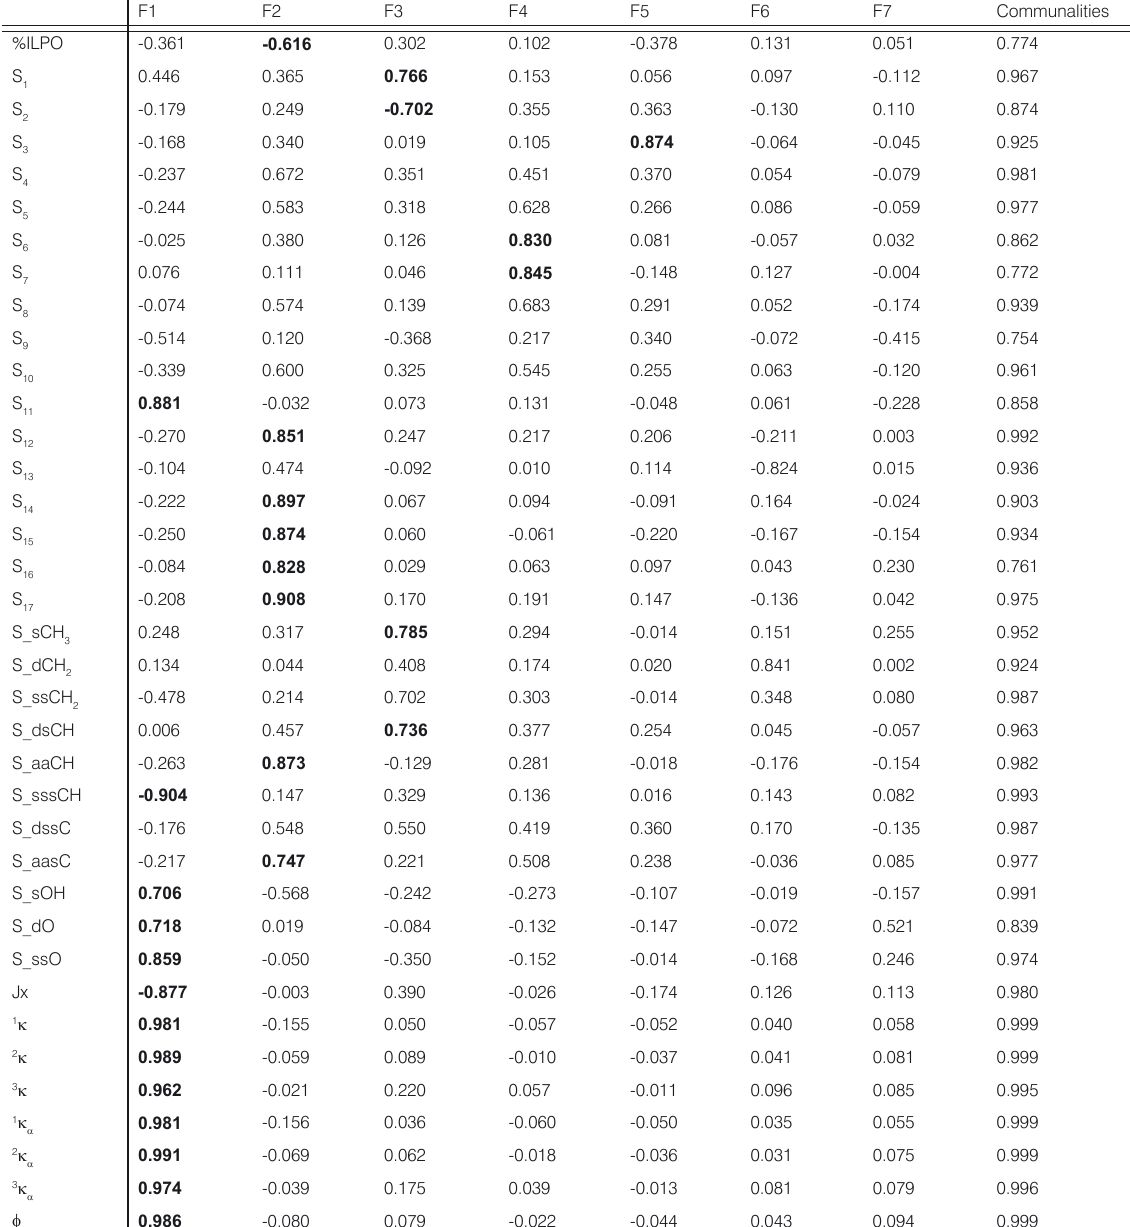
) and predictor variables) after VARIMAX LPO